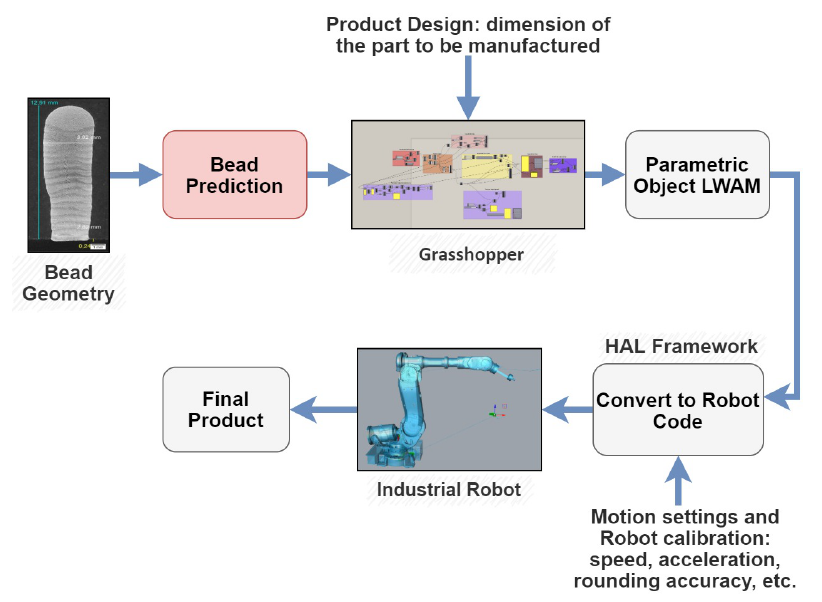
Figure 2. Flowchart diagram of the proposed approach for the LWAM